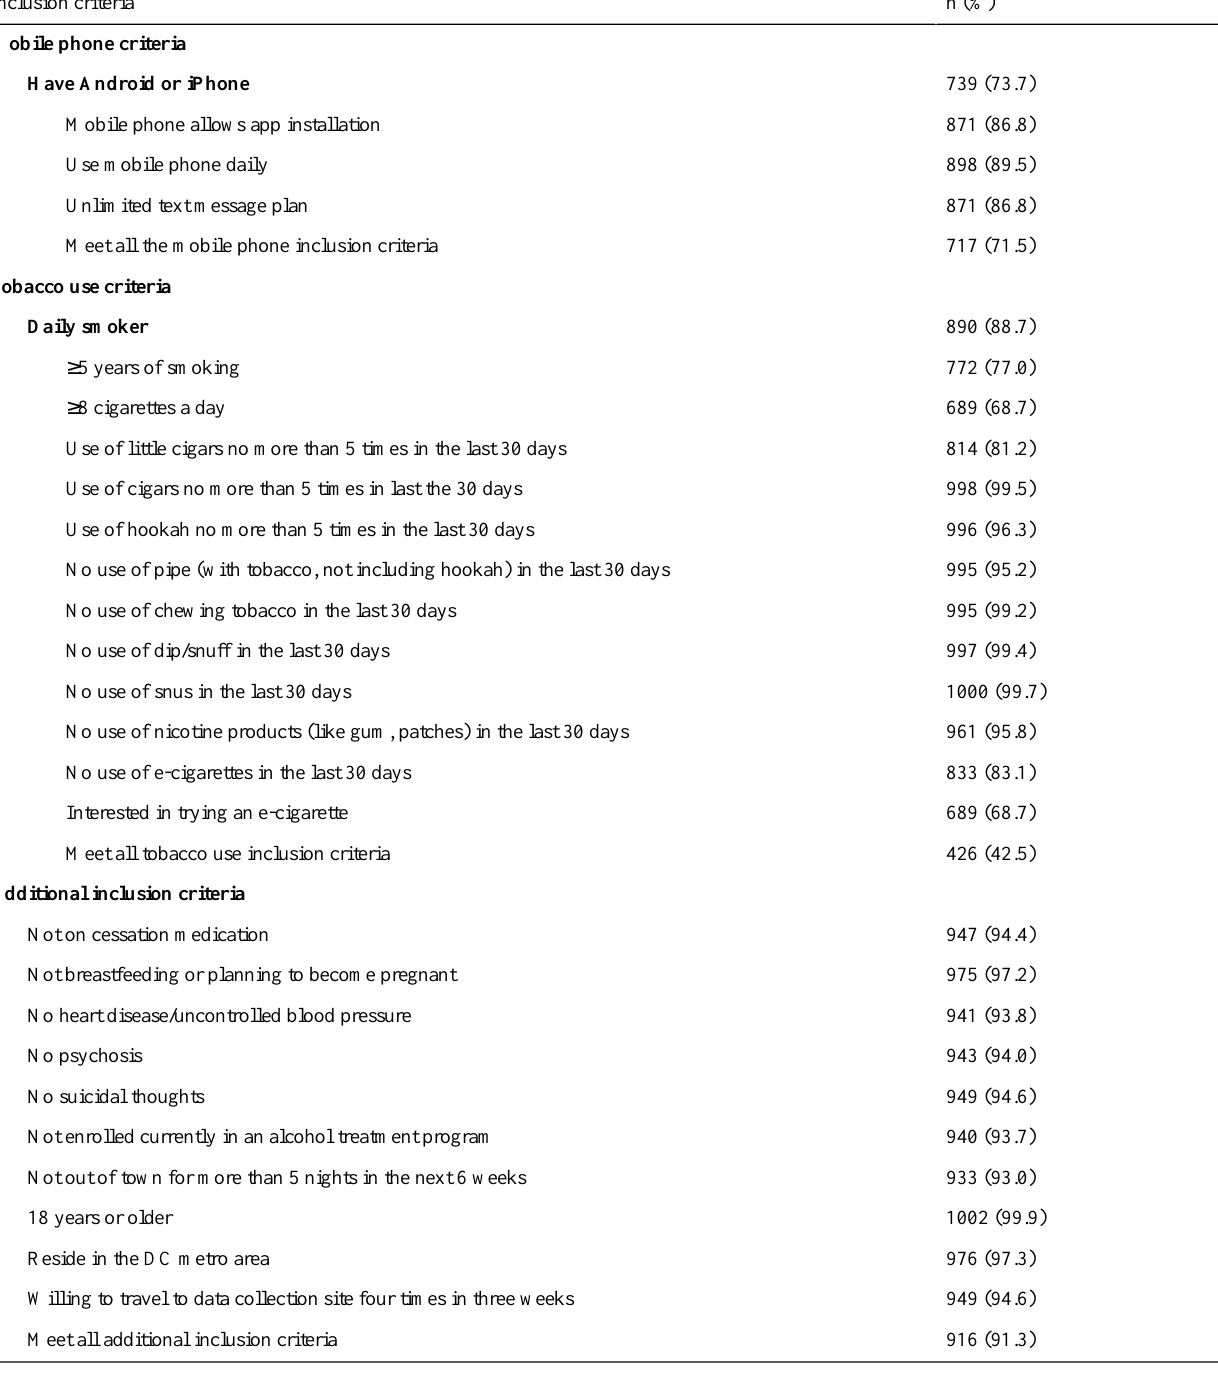
Table 2. Percentage of screened individuals who satisfied mobile phone, tobacco use, or additional inclusion criteria in the online screener (N=1003).